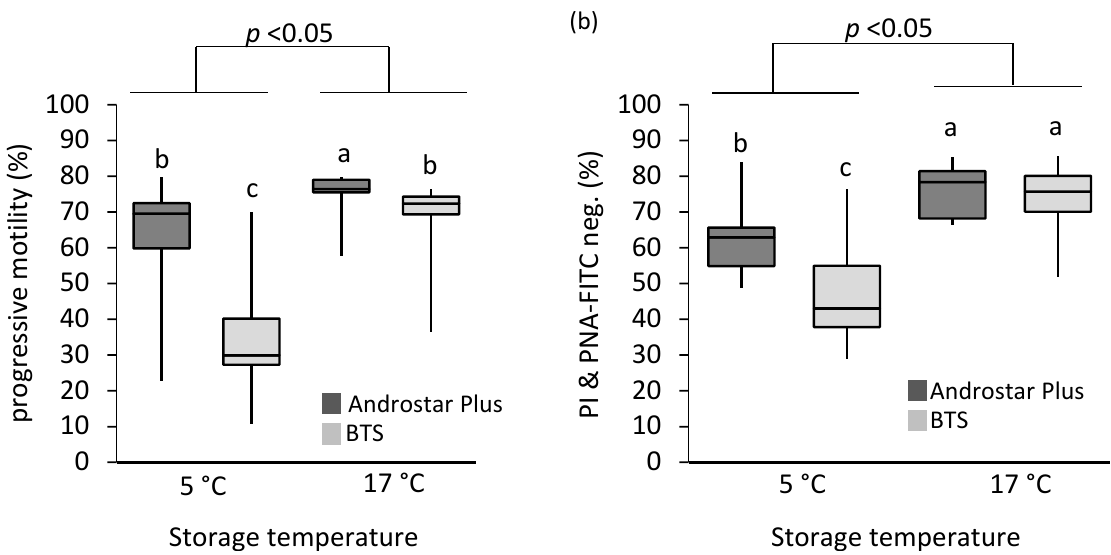
Figure 1. Effect of storage temperature and semen extender on progressive motility and viability of boar spermatozoa. Storage temperature (5 °C or 17 °C) and semen extender (Beltsville Thawing So- lution (BTS) or Androstar ® Plus) had a significant impact on ( a ) progressive motility and ( b ) the number of viable spermatozoa with intact acrosomal membrane (PI & PNA-FITC negative) after 24 h preservation. Different lower-case superscripts indicate significant differences based on Wilcoxon signed-rank test ( a ) or Student’s t -test for paired samples ( b ; all n = 7 boars; all p < 0.05). Table 1. Comparison of CASA kinematic parameters for semen samples after 24 h storage in Belts- ville Thawing Solution (BTS) or Androstar ® Plus at 17 °C or 5 °C ( n = 7 boars). Different superscripts (a–d) within a row indicate significant differences. Results are based on Student’s t- test for paired samples unless otherwise indicated ( p < 0.05). Data are presented as mean and standard deviation.